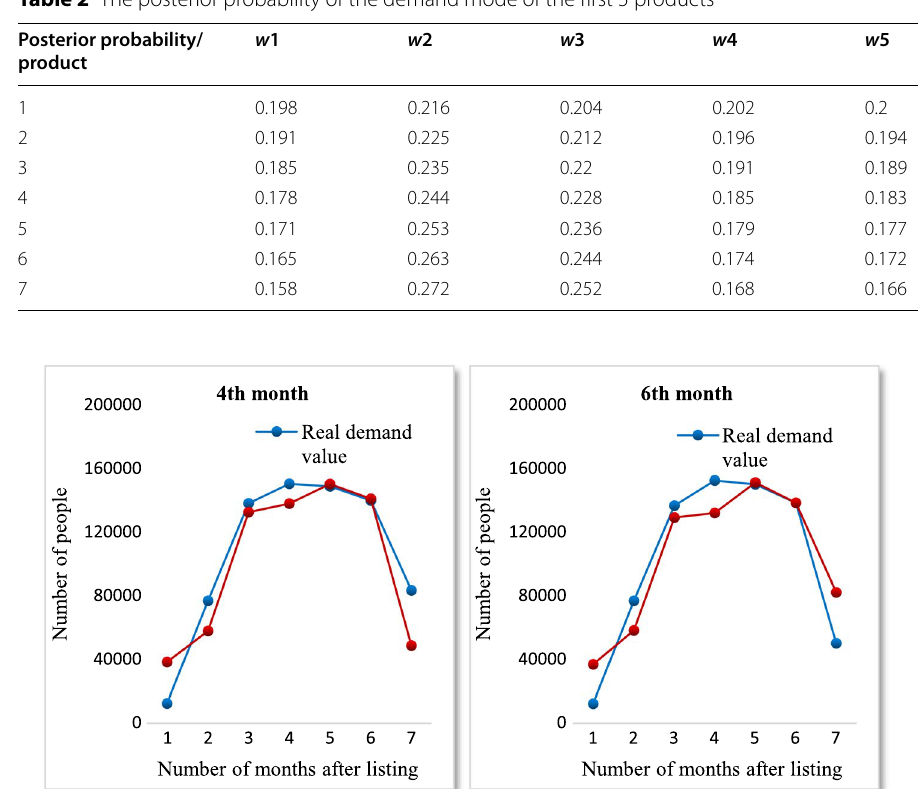
Fig. 10 Comparison of forecasted and true demand values in the 4th and 6th